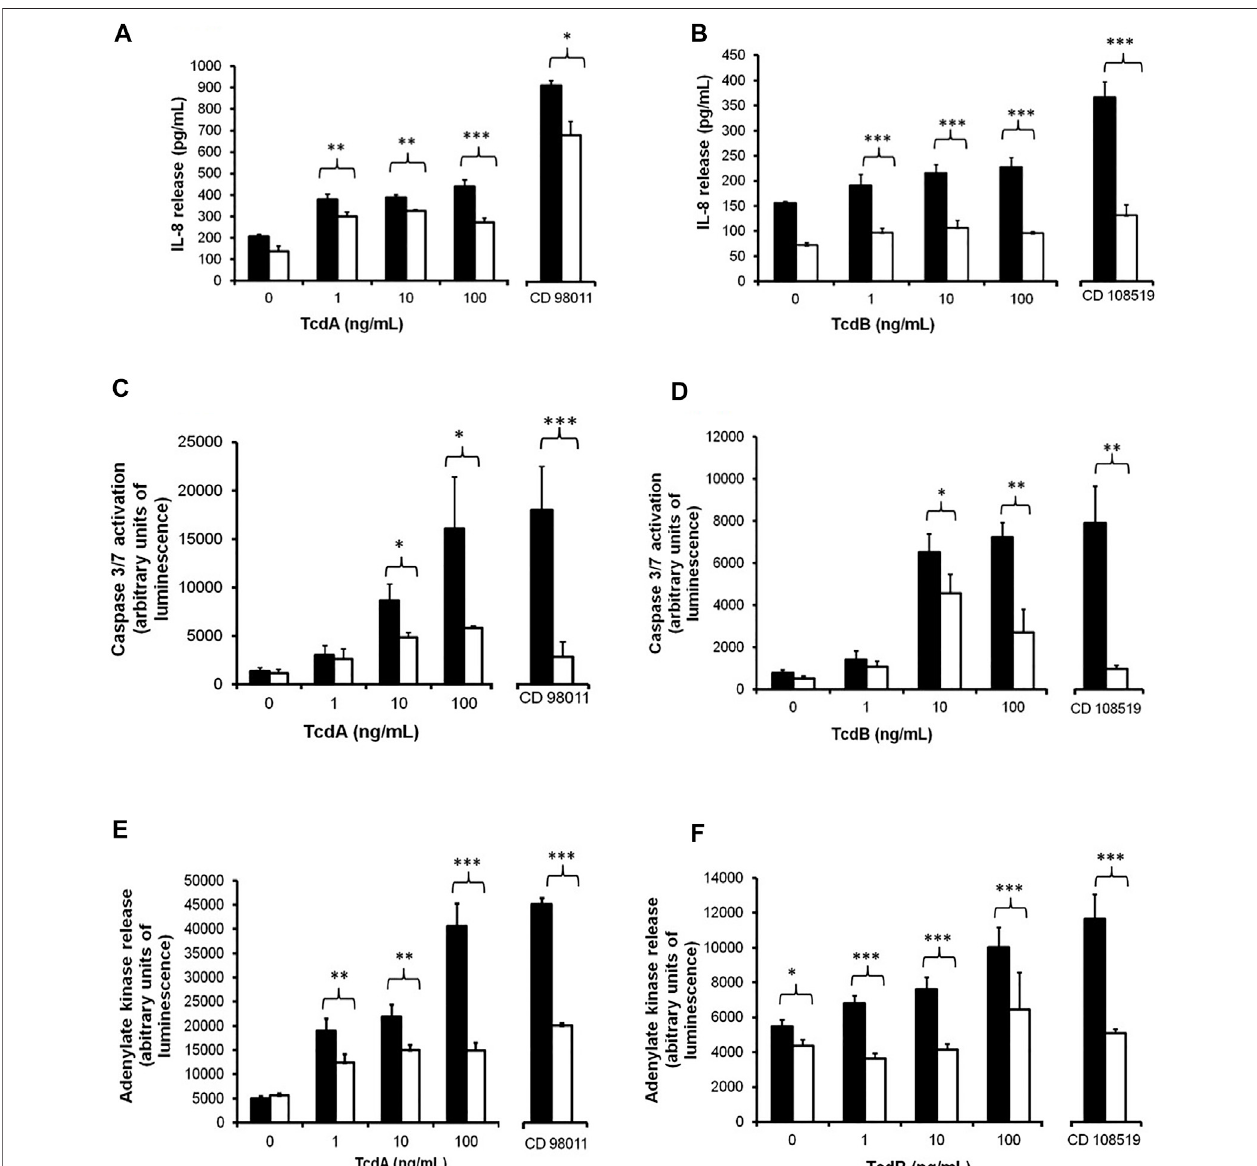
FIGURE5| Soluble NSP from plantainreduces C.dif fi cile bacterium and toxinAand toxin Bmediated in fl ammation,cellular apoptosisand cytotoxicity inintestinal epithelial cells. Caco-2cell monolayers weretreatedwith C.dif fi cile toxinsA (TcdA)or toxin B(TcdB), at 1 – 100 ng/ml for24 h, in theabsence(black bars)or presence of 10 mg/ml plantain NSP (white bars). In parallel, Caco-2 cells were infected with the TcdA+/TcdB+/CDT + C. dif fi cile isolate 98011 or the TcdB + C. dif fi cile isolate 108519, at a multiplicity of infection (MOI) of 100 for 4 h, again in the absence or presence of plantain NSP. Media harvested from cells was analysed for release of IL-8(byELISA)andcytotoxicitymarkeradenylatekinase(byToxilightbioassay).Apoptoticcelldeathwasmeasured usingtheCaspaseGlo3/7assay. Inthepresenceof plantain NSP, TcdA- and TcdB-mediated (A,B) IL-8 release, (C,D) caspase 3/7 activation, and (E,F) cytotoxicity (intracellular adenylate kinase release) were all signi fi cantly reduced ( N (cid:2) 2, n (cid:2) 3; * p < 0.05, ** p < 0.01, *** p < 0.001; Kruskal-Wallis test).